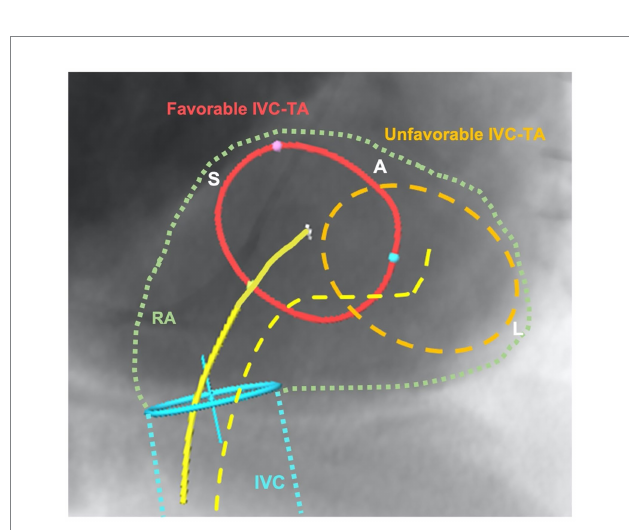
FIGURE 2 Illustration of favorable and unfavorable relationship between inferior vena cava and tricuspid annulus (IVC-TA). This figure demonstrates a short-axis view of the tricuspid annulus and the inferior vena cava course (blue) and entry into the right atrium (green) using CT- fluoroscopic fusion imaging. The favorable anatomy (red) shows no major offset compared to the unfavorable IVC-TA, where the annulus is completely offset laterally from the IVC origin. The yellow lines depict the secondary flexion required to achieve coaxiality, with the dotted line requiring severe secondary flexion, a movement that will impact primary movements and ability to be coaxial with tricuspid valve. IVC, inferior vena; TA, tricuspid annulus; RA, right atrium; S, septal; A, anterior; L,